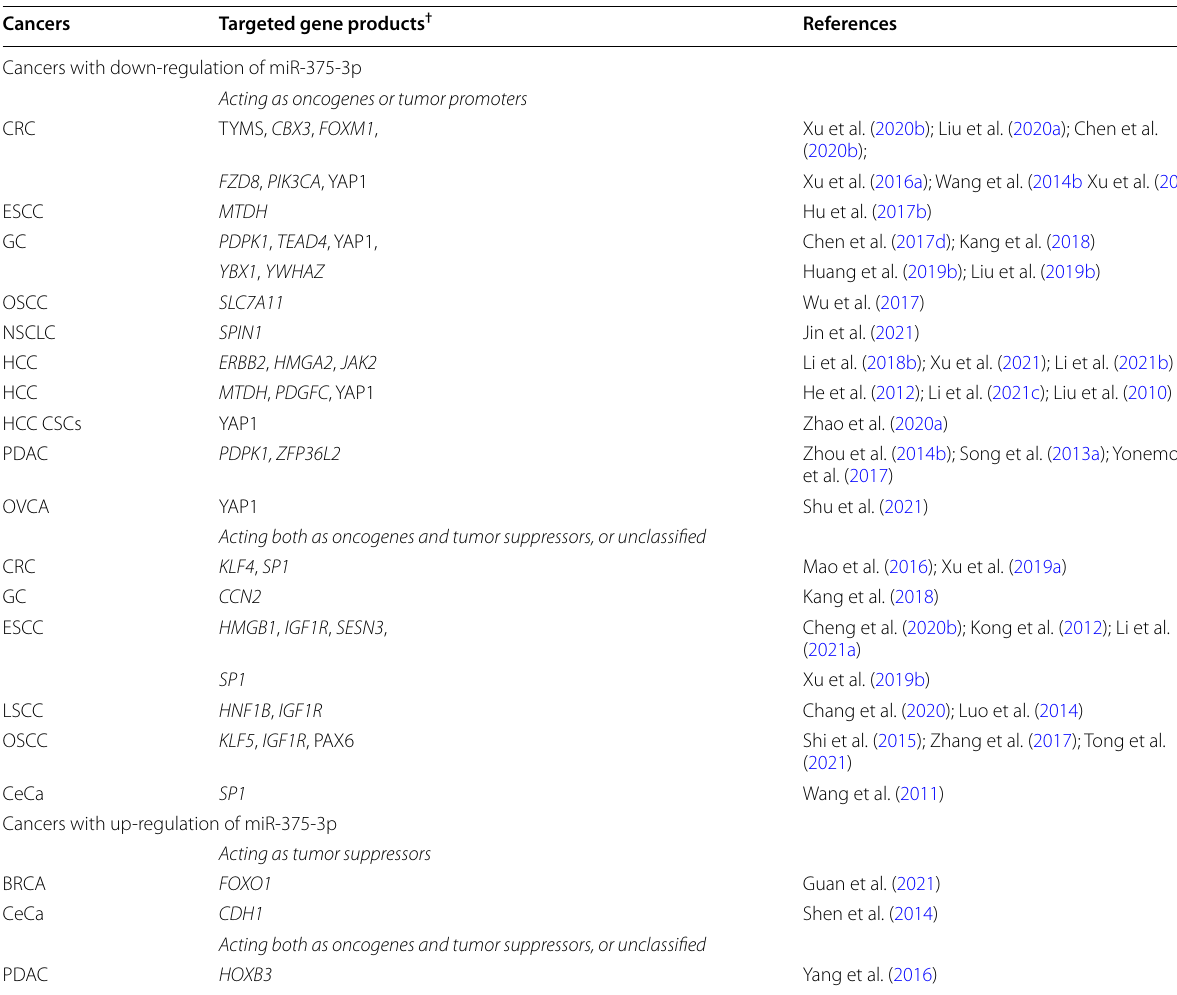
Table 13 Major genes targeted by miR-375-3p in various types of